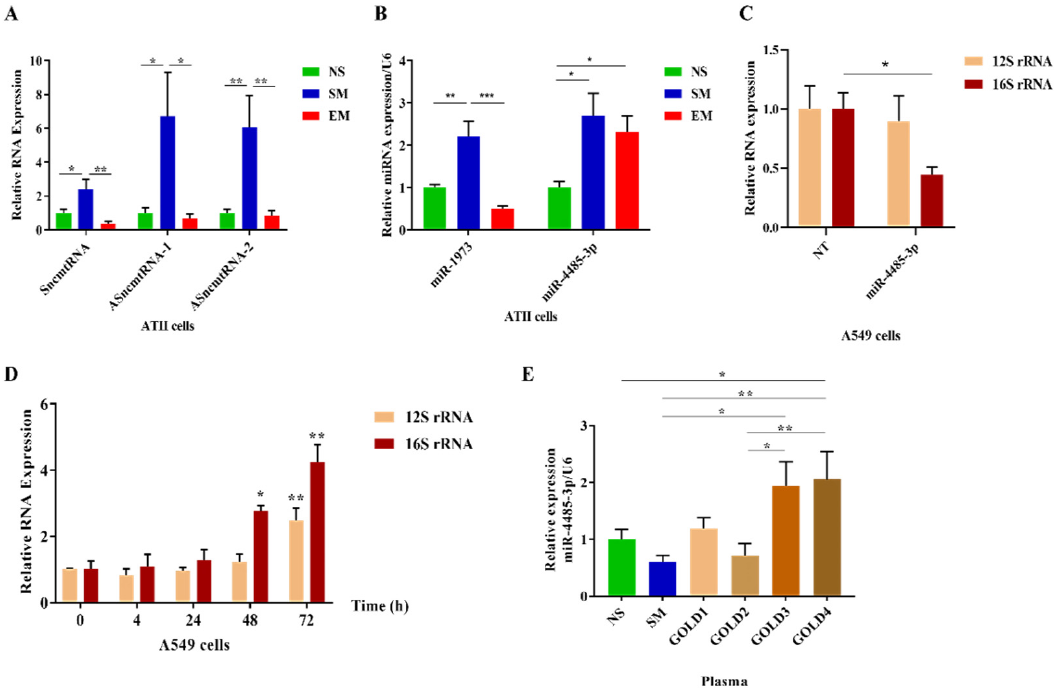
Figure 7. Increased miR4485-3p expression in emphysema. ATII cells were isolated from nonsmokers (NS), smokers (SM), and emphysema patients (EM). ( A ) Sense SncmtRNA and anti-sense ASncmtRNA-1 and ASncmtRNA-2 RNAs levels were normalized to GAPDH and determined by RT-PCR. ( B ) mir1973 and mir4485-3p expressions were normalized to U6 and analyzed by RT-PCR. ( C ) A549 cells were transfected with miR-4485-3p or NT for 72 h, and 12S and 16S rRNA expression was determined by RT-PCR and normalized to GAPDH (N = 3 biological replicates). ( D ) A549 cells were treated with CSE for 4 h, 24 h, 48 h, and 72 h. The expression of 12S and 16S rRNA was determined by RT-PCR and normalized to GAPDH (N = 3 biological replicates). ( E ) Plasma samples obtained from NS, SM, and COPD (GOLD1–GOLD4) were used to assess the expression of circulating mir-4485-3p (N = 4–9 per group). Results were normalized to U6 and analyzed by RT-PCR. Data are shown as means ± s.e.m (* p < 0.05; ** p < 0.01; *** p < 0.001).